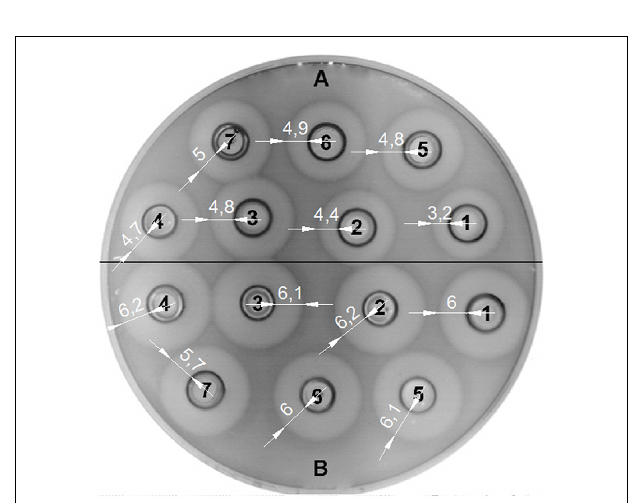
FIGURE 4 |Activity of LcnB synthesized by BGMN1-501 and BGMN1-501/pG + host9prtP (PrtP – mutant) after growth in GM17 media with different concentration of casitone. (A) LcnB activity of BGMN1-501 after growth in GM17 with (1) 0%; (2) 0.5%; (3) 1%; (4) 2%; (5) 4%; (6) 6%; (7) 8%; of casitone.The zones of growth inhibition enlarge as the concentration of casitone grows; (B) LcnB activity of BGMN1-501/pG + host9prtP (PrtP − mutant) after growth in GM17 with (1) 0%; (2) 0.5%; (3) 1%; (4) 2%; (5) 4%; (6) 6%; (7) 8%; of casitone. Note that the zones of growth inhibition are not dependent on casitone concentration in the